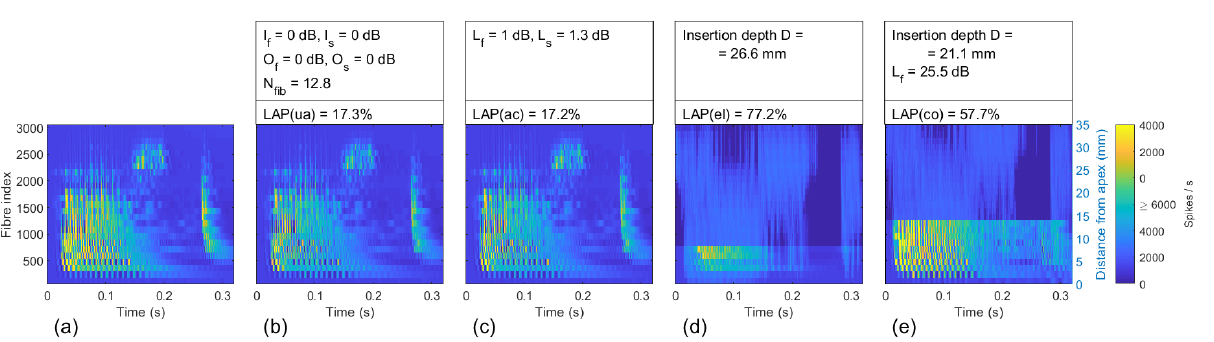
Figure 7. AN firing rates with regard to fiber index and time. The subject showed moderate to severe severe CS. ( a ) Normal hearing reference. ( b ) Unaided hearing, with hearing loss parameters (I f , I s , O f , O s , and N fib ). ( c ) Sole acoustical amplification, with amplification parameters (L f and L s ). ( d ) Sole electrical stimulation, with insertion depth of the CI. ( e ) Electrical stimulation combined with acoustic amplification, with insertion depth of the CI and amplification parameter L f . LAP refers to the cost-adjusted loss of action